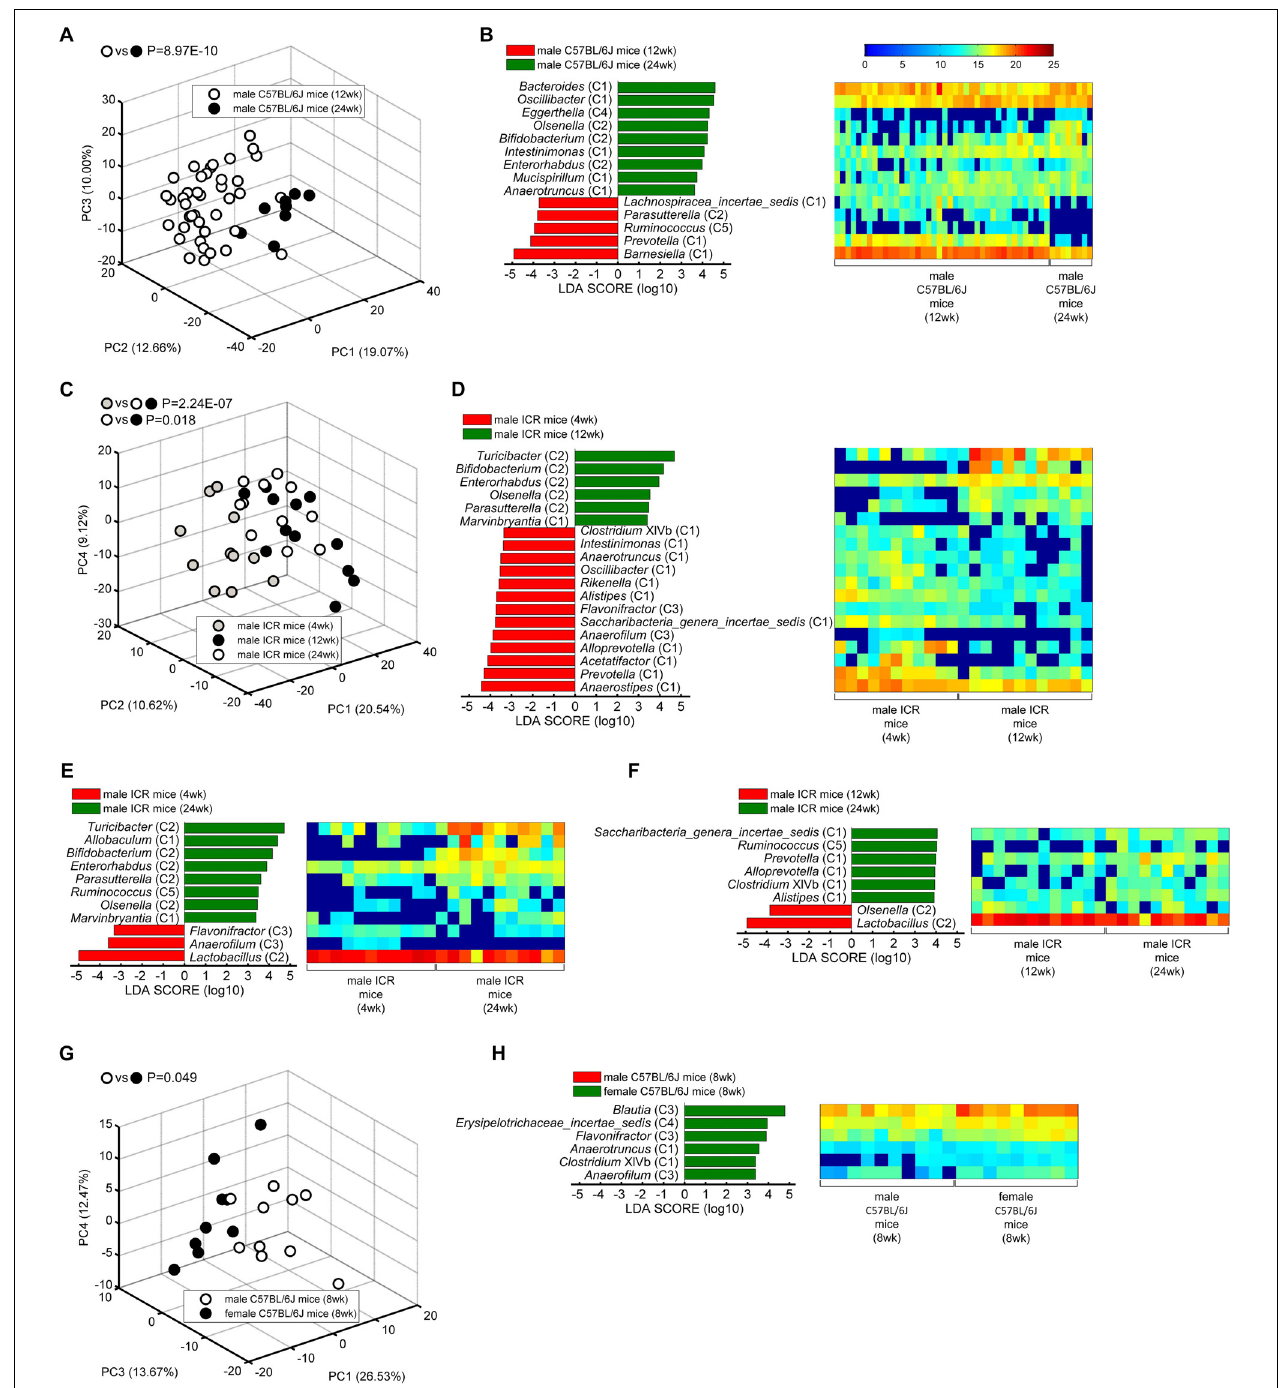
FIGURE 3 | The core bacteria showed significant age- and sex-associated structural segregation. (A,C,G) PCA score plot based on the core genus abundance of healthy mice in dataset PRO (A) , CUG (C) , and FMT (G) . Each circular point represented the fecal core microbiota of a healthy mouse. P -values were calculated with MANOVA test, and shown on the top of PCA plots. (B,D–F,H) The different abundance of bacterial genus between the two groups were identified by LEfSe. It was significantly different when alpha value of the factorial Kruskal–Wallis test was < 0.05 and the logarithmic LDA score was > 2.0. The left histogram showed the LDA scores of genera differentially abundant between the two groups. The taxonomy was listed, followed by its core group. The right heatmap showed the relative abundance (log 2 transformed) of the differential genera. n = 40 for male C57BL/6J mice (12 weeks), n = 8 for male C57BL/6J mice (24 weeks), n = 11 for male ICR mice (4 weeks), n = 12 for male ICR mice (12 weeks), n = 11 for male ICR mice (24 weeks), n = 10 for male C57BL/6J mice (8 weeks), and n = 9 for female C57BL/6J mice (8